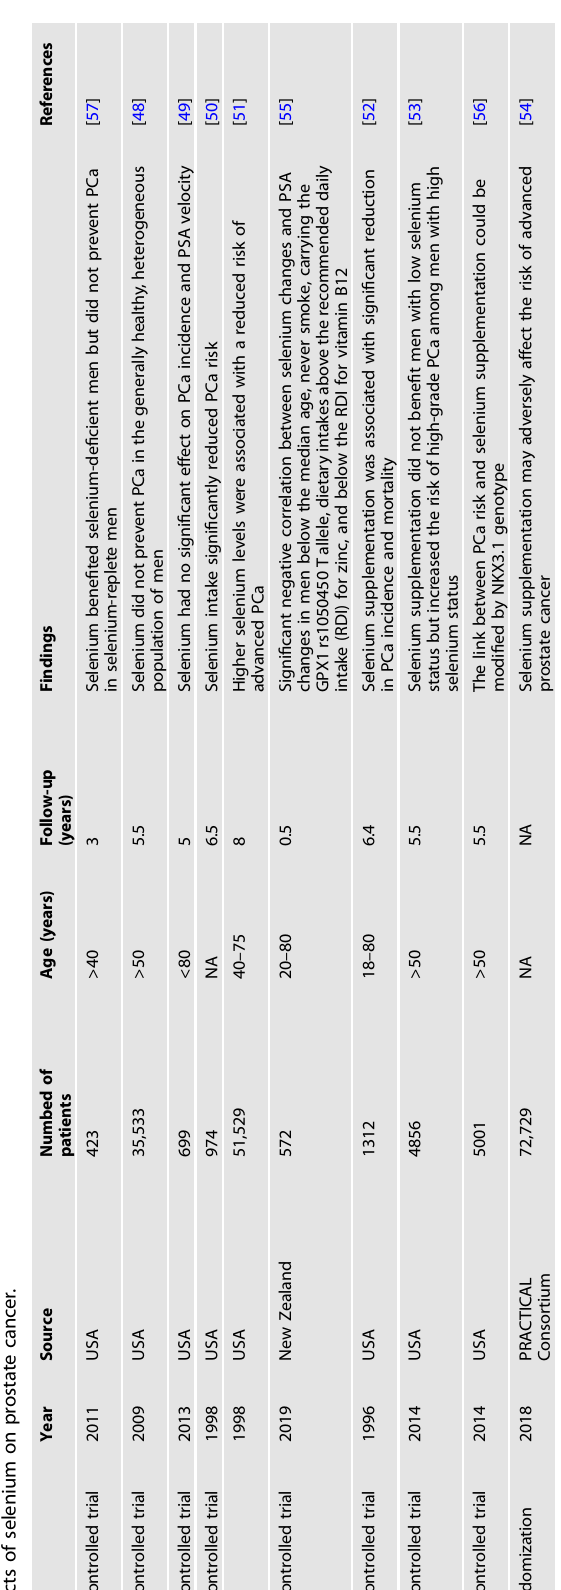
arachidonic acid metabolism by upregulating PLA2G4A to avoid ferroptosis in cancer cells [65]. The Acyl-CoA synthetase long-chain family member 4 (ACSL4) activates PUFAs to form long-chain acyl- CoAs and attaches to the cell membrane, which powers ferroptosis because it increases the ratio of polyunsaturated fatty acids in the membrane, making cells more susceptible to ferroptosis [66, 67]. The ACSL4 expression is up-regulated in several types of cancers (including ER-negative breast, colorectal and prostate cancers) and down-regulated in others (ER-positive breast, lung and cervical cancers). ACSL4 positively correlates with PCa cell proliferation, migration and invasion, and this correlation exists both in vivo and in vitro. A signi fi cant increase in ACSL4 was also observed when entering the castration-resistant phase, suggesting that ACSL4 expression may contribute to castration- resistant prostate cancer (CRPC) [68]. Furthermore, the use of inhibitors targeting ACSL4 reduced prostate tumor growth, resistance to related treatments, and steroid production, con fi rm- ing this speculation [69]. By contrast, ACSL3, mainly located in the brain, prostate and muscle, is responsible for the activation and conversion of monounsaturated fatty acids (MUFA) into fatty acyl- CoA, competitively inhibiting PUFA-associated ferroptosis by altering the proportion of cell membrane components [70 – 72]. In addition, ACSL3 can promote the development of CRPC by increasing steroid production [73]. In nude mice, ACSL3 can promote tumor growth, and high expression of ACSL3 in PCa patients also predicts poorer prognosis [74]. As a rate-limiting enzyme, stearoyl-coenzyme A desaturase 1 (SCD1) can inhibit ferroptosis by converting saturated fats acids to monounsaturated fats acids (MUFA). Yi et al. found that silencing of sterol regulatory element-binding proteins 1 (SREBP1) reduced SCD1 expression to promote lipid peroxidation and induce ferroptosis in PCa cells [75]. In addition, the researchers also found that the PI3K/AKT/mTOR pathway can inhibit ferroptosis through the SREBP1-SCD1 axis, but the relationship between the PI3K/AKT/mTOR pathway and PCa in terms of ferroptosis remains unclear. 2,4-Dienoyl-CoA reductase 1 (DECR1) can limit the rate of PUFA oxidation, and its expression is signi fi cantly increased in prostate tumors and castration-resistant mice, but the opposite is observed in breast cancer [76, 77]. DECR1 knockdown selectively inhibits PUFA β -oxidation leading to cellular accumulation of PUFA, leading to excess accumulation of PUFA in cells, providing raw material for oxidative stress and ferroptosis [78]. Lipoxygenase, a non-heme iron- or manganese-containing oxygenase with the ability to oxidize polyunsaturated fatty acids and their derivatives in cell membranes, plays a key role in ferroptosis [79]. In PCa, 5-Lipoxygenase (5-LOX), 12-Lipoxygenase (12-LOX), and 15-Lipoxygenase (15-LOX) have always been the research hotspots. Numerous studies have shown that 5-LOX can be a target of ferroptosis, and inhibition of 5-LOX can reduce the risk of cellular ferroptosis by neutralizing lipid peroxidation [80]. 5-LOX can combine with AA to generate 5-HETE (5-hydroxyeico- satetraenoic acid), which is a potent survival factor for PCa cells. When the formation of 5-HETE is blocked, PCa cells undergo apoptosis in a very short time, which can be rescued by exogenous 5-HETE [81]. 12-LOX is upregulated in PCa, and it stimulates the growth and generation of tumor blood vessels to promote PCa progression [82]. Interestingly, as a member of the lipoxygenase family, in addition to its function of oxidizing PUFAs, 12-LOX induces P53-mediated ferroptosis, and this pathway is ACSL4-independent, which is essential for p53-dependent tumor suppression [83]. 15-LOX2, as the main lipoxygenase in normal prostate, has the function of negatively regulating the cell cycle of prostate epithelial cells and can inhibit the occurrence of prostate cancer. When normal cells undergo malignant transformation, its expression level will decrease [84]. 15-LOX can bind to and oxidize PUFAs in the membrane under the guidance of PEBP1 (Protein Kinase Cascade Inhibitor), thereby promoting ferroptosis [85]. T a